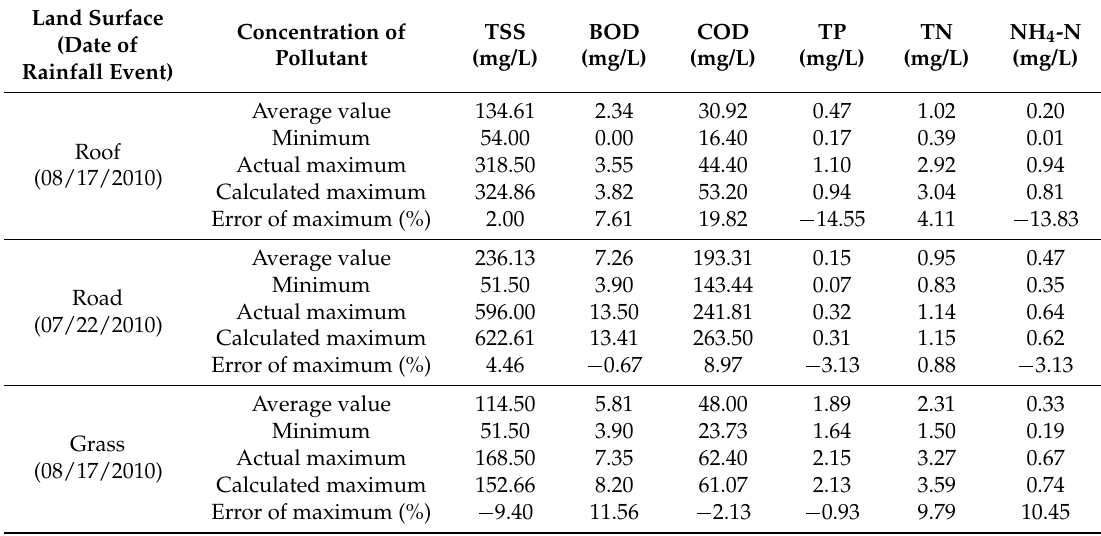
Table 2. Comparison of actual and calculated water qualities for model